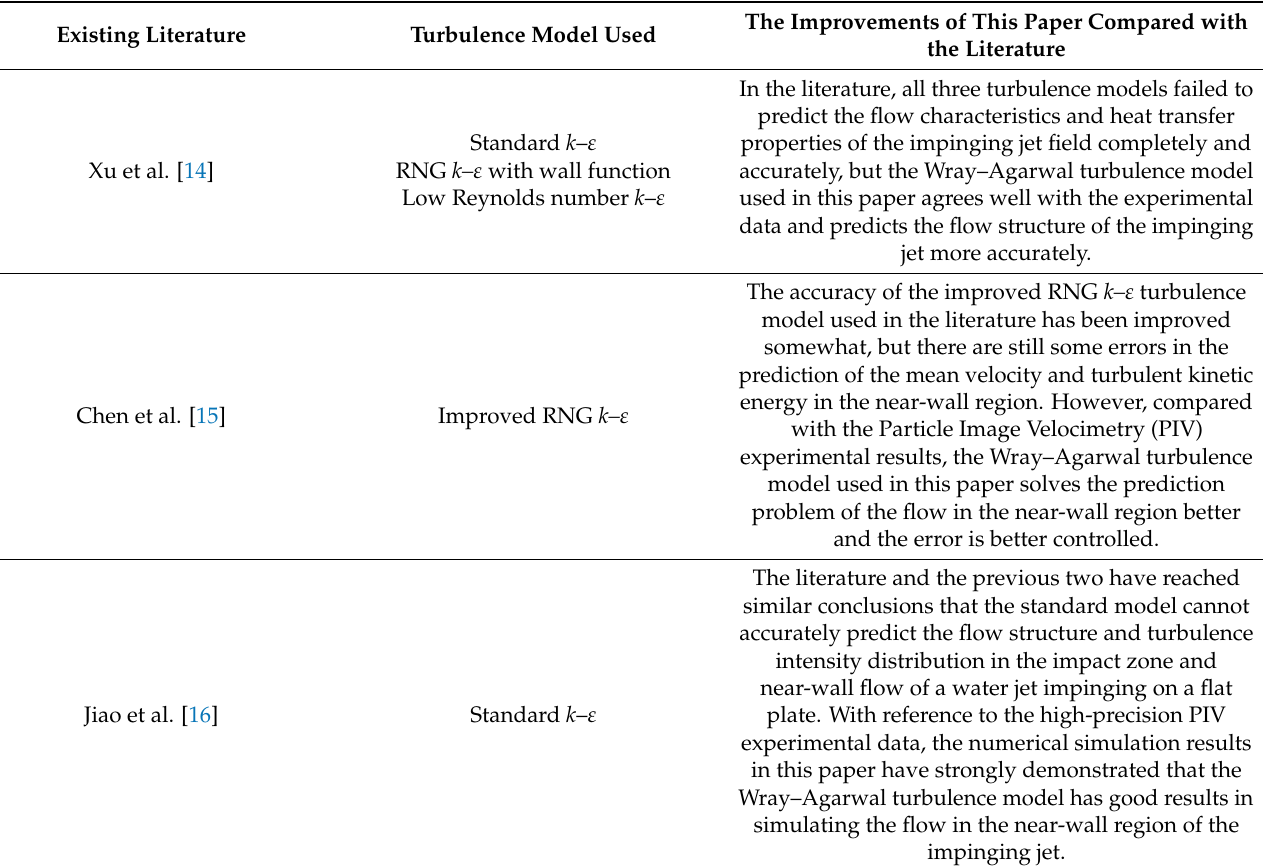
Table 1. The advantages and improvements of this paper, compared with existing